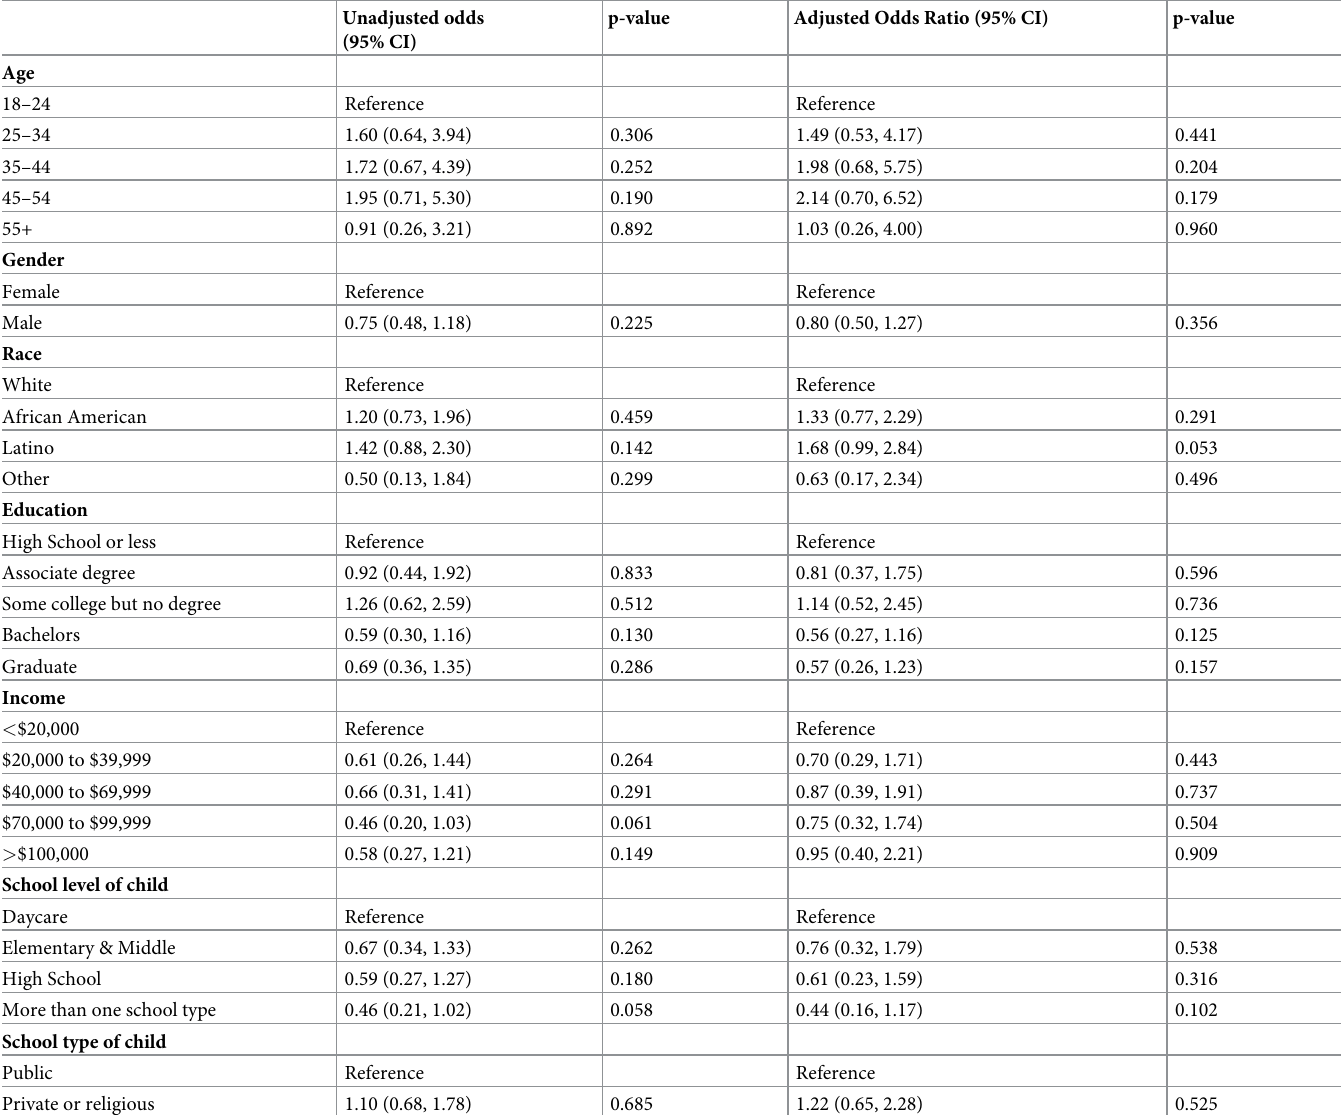
Table 2. Results from multivariable logistic regression models estimating unadjusted and adjusted odds ratio for demographic characteristics associated with parents’ plans to not have their child return to school. Unadjusted odds (95%